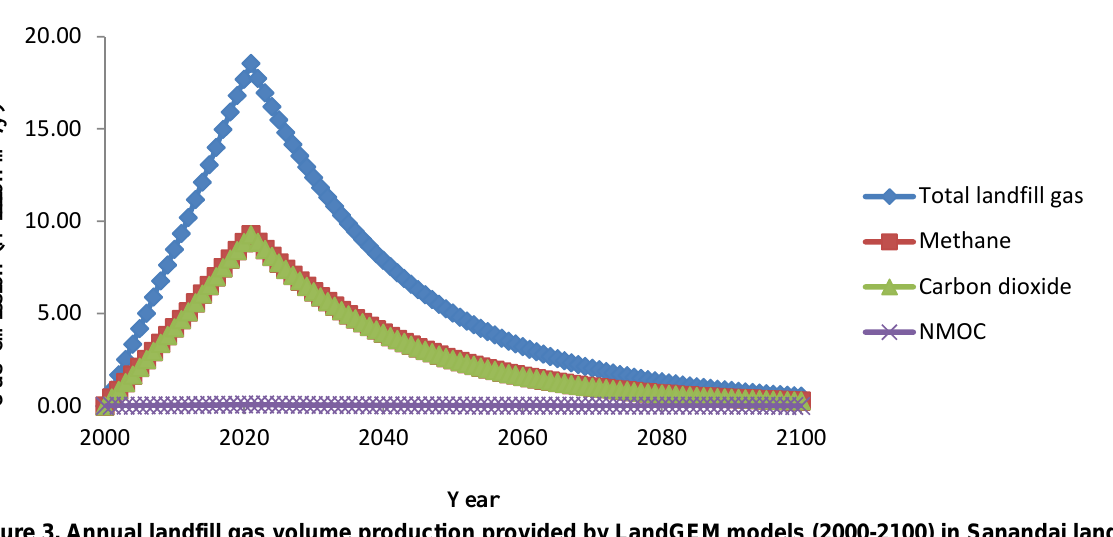
Figure 2. Annual landfill gas mass production provided by LandGEM models (2000-2100) in Sanandaj landfill k = 0.045 (/year), L 0 = 200 (m 3 /ton), non-methane organic compound (NMOC) = 4000 ppmv, methane = 50%